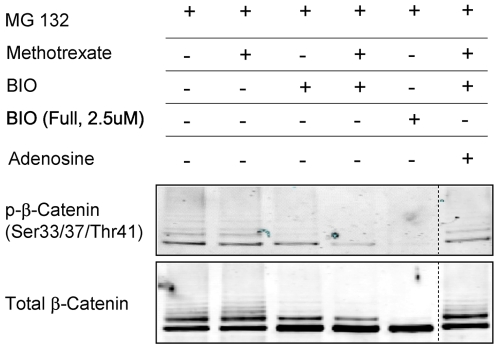
Methotrexate enhances BIO-mediated inhibition of phosphorylation at GSK3-specific residues (Ser33/37/Thr41) on β-catenin.RKO-BAR cells were treated with the proteasome inhibitor MG132 alone (1 µM), or in combination with other compounds as depicted, and subjected to immunoprecipitation with a β-catenin specific antibody followed by Western blot for total and phospho- (Ser33/37/Thr41) β-catenin. Exposure of cells to suboptimal BIO (312 nM) plus methotrexate (312 nM) led to a greater decrease in phosphorylated β-catenin than exposure to the same dose of BIO alone (compare lanes 4 and 5). As observed with β-catenin accumulation (Figure 2), further exposure to adenosine (100 µM) neutralized the impact of methotrexate on BIO-mediated inhibition of β-catenin phosphorylation. The dashed line denotes that the adenosine treated sample is from a separate part of the same blot. This result is representative of three separate experiments.